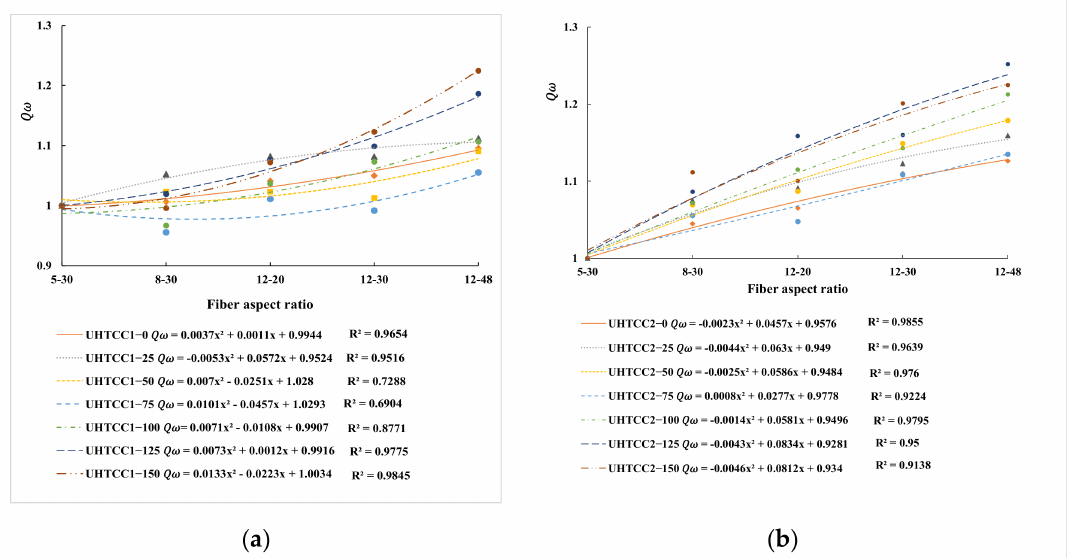
Figure 7. The relationship between the contribution rate and aspect ratio of modified PP fiber: ( a ) fiber content of 1%; ( b ) fiber content of